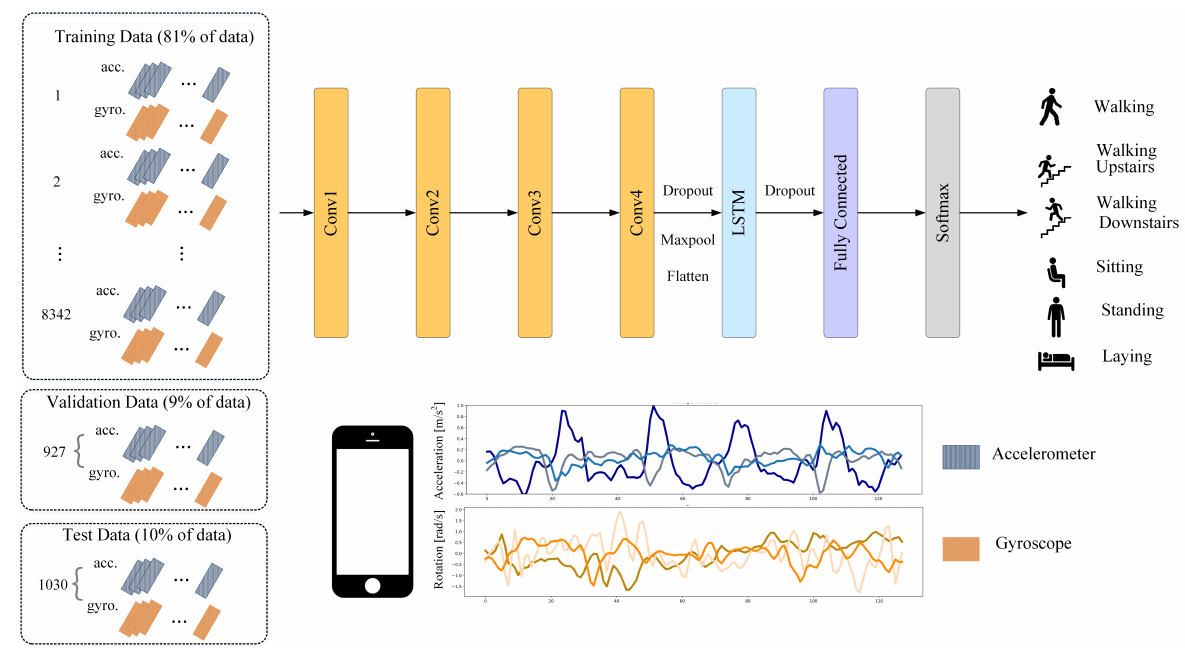
Figure 14. The proposed architecture of 4-layer CNN-LSTM